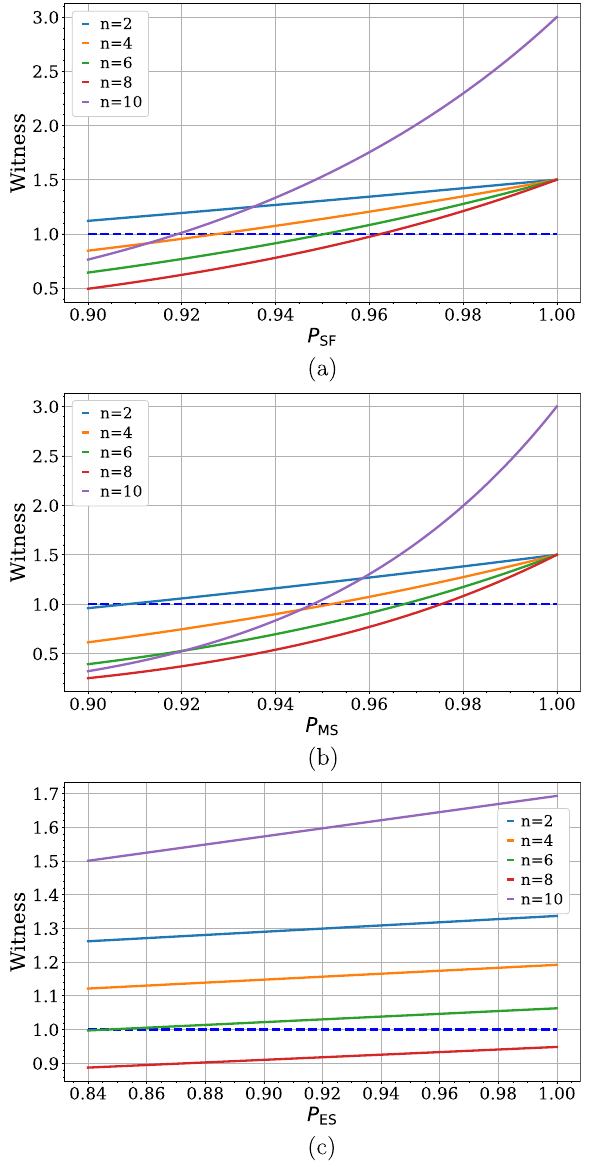
Fig. 5 The value of witness of Eq. (16) in Section 2.4 by taking account of errors in (a) spin- fl ip, (b) spin-measurement, and (c) entangling step. In (c) P SF and P MS are taken to be 0.98 and 0.985, respectively. Here the system contains N = 10 qubits and the subsystems are chosen according to Eq. (34) with qubit number n = 2, 4, 6, 8, 10. The blue dashed line shows the lower bound of the witness that can certify the